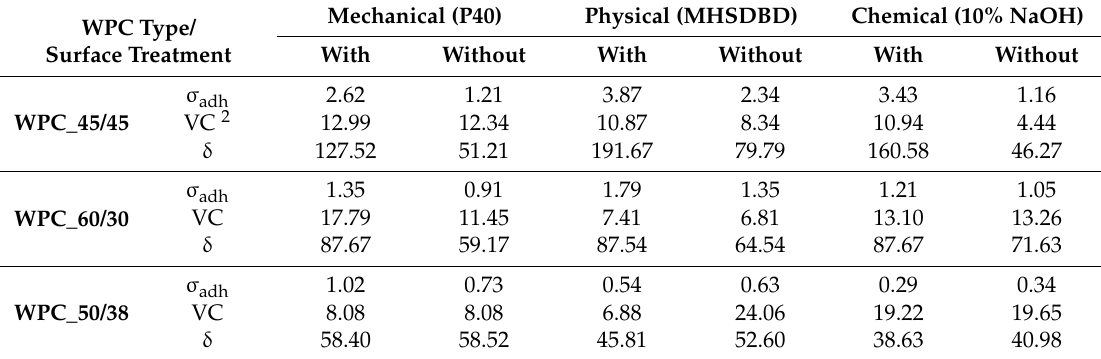
Table 4. Average tensile stress σ adh (in MPa), variation coefficient (in %) and tensibility (in %) of samples WITH and WITHOUT primer 1